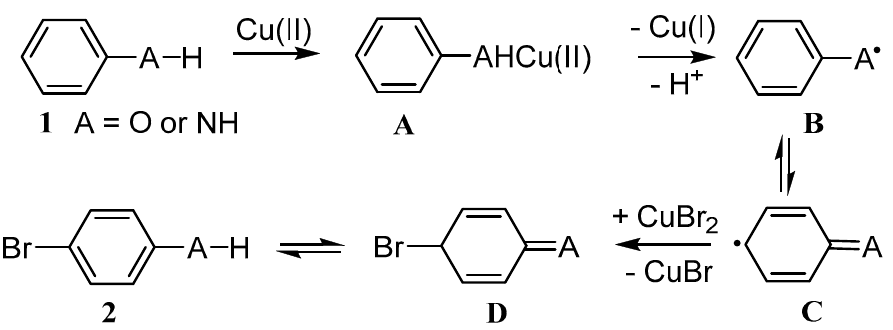
Scheme 5. The suggested single electron transfer (SET) mechanism for the bromination of anilines or phenols [36,37].